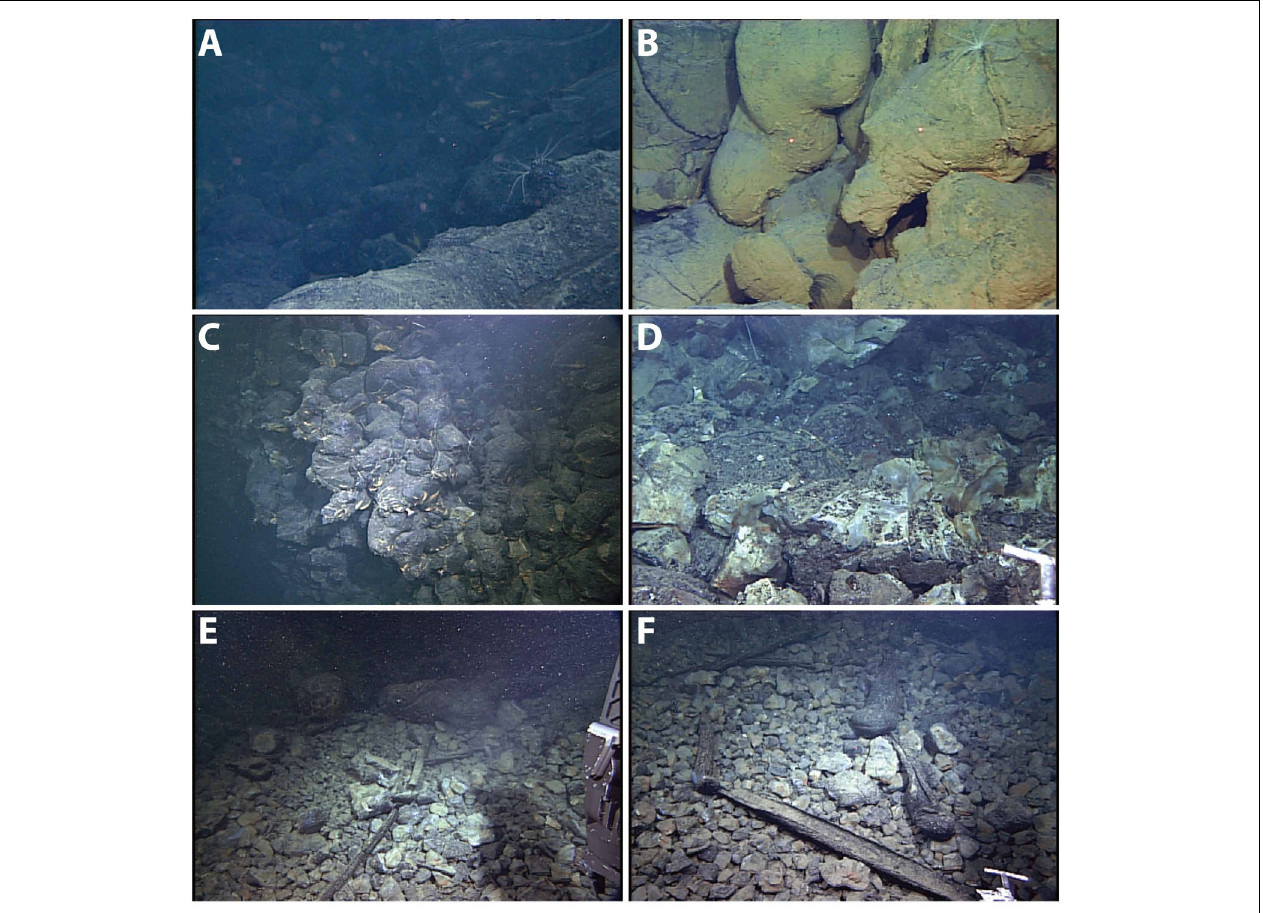
FIGURE 4 | Video framegrabs from dive T885; images B , D , and F are 2–3 m across and A , C , and E are 4–5 m across. (A) Contact showing black 1996 lava pillows (upper left) on top of slightly altered and sediment-covered older flow (lower right). Image taken at 3058 m depth at 42.686030 ◦ , –126.780538 ◦ . (B) Elongate 1996 pillow lavas with thin yellow-brown hydrothermal deposits. Photo taken 9 years after the eruption. Image taken at 3052 m depth at 42.686072 ◦ , –126.7804625 ◦ . (C) Upper surface of northern pillow mound with vertical to overhanging scarp to left. Image taken at 3053 m depth at 42.685767 ◦ , –126.7795013 ◦ . (D) Pillow talus at base of scarp with scattering of glass shards produced when pillow fragments fall down scarp and glass rinds spall off. Image taken at 3115 m depth at 42.683628 ◦ , –126.781378 ◦ . (E) Lavacicles found on top of talus at base of vertical scarp. These form as molten lava cascades over the scarp and drip as vertical cylinders of lava. Image taken at 3101 m depth at 42.685471 ◦ , –126.779523 ◦ . (F) Lavacicles showing teardrop shapes formed at bottom of lavacicles. Some lavacicles have slightly bent ends showing that they were still plastic when they fell to the talus slope. Image taken at 3101 m depth at 42.685447 ◦ , –126.779418 ◦